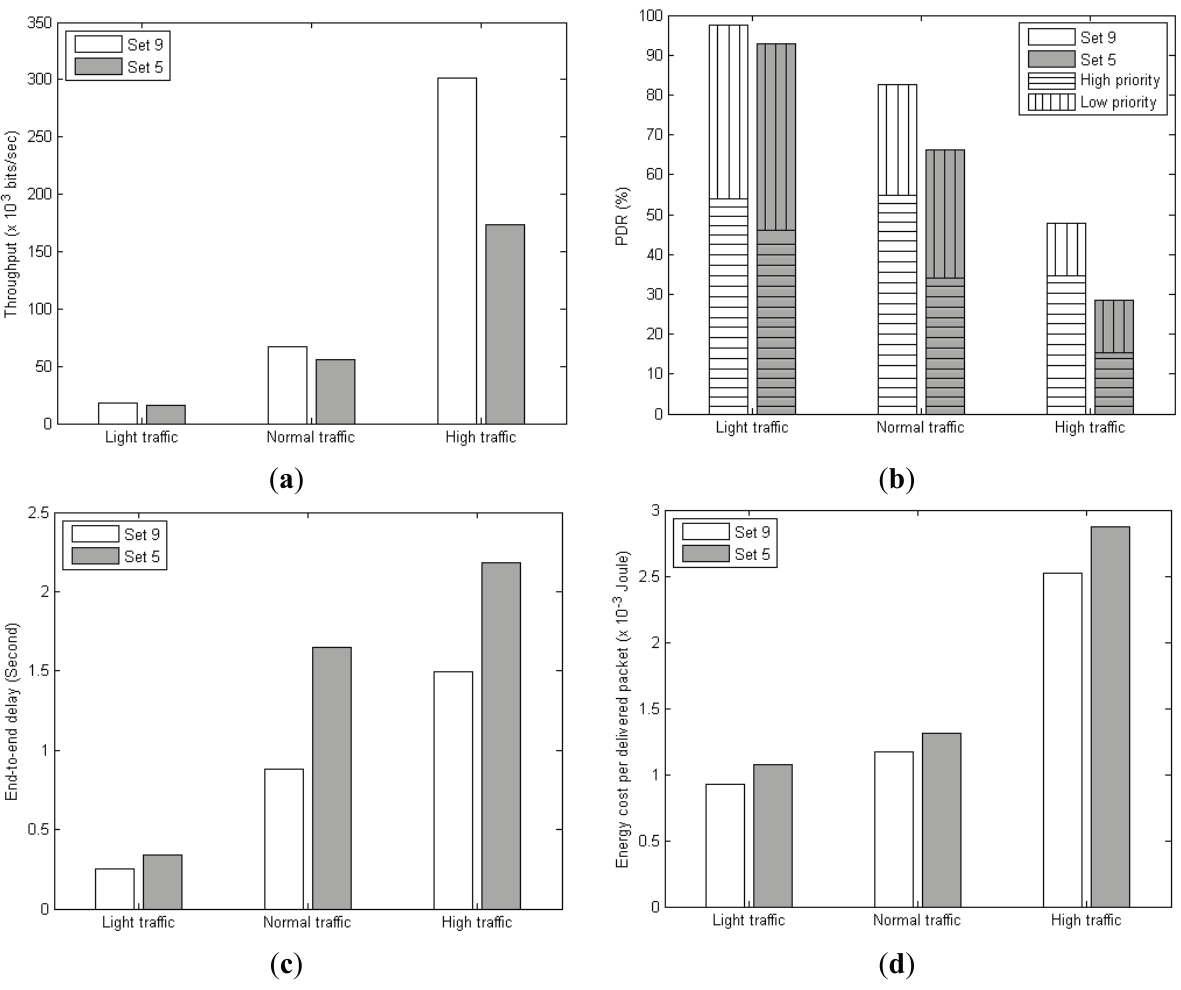
Figure 21. ( a ) Throughput; ( b ) PDR; ( c ) End-to-end delay; and ( d ) Energy cost comparison between context-aware and non-context aware DR-MAC/DAAM protocol